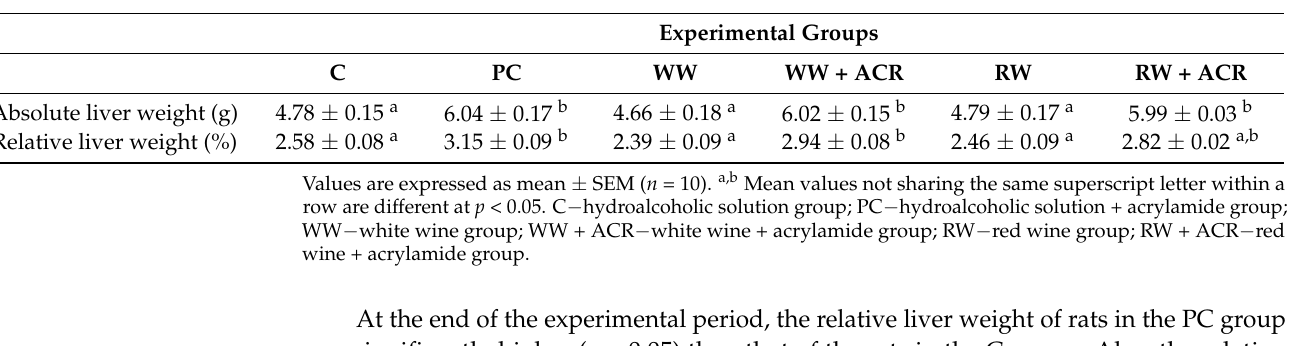
Table 3. Effects of white/red wine on absolute liver weight and relative liver weight (% of body weight) of rats in the 6 experimental groups at the end of the